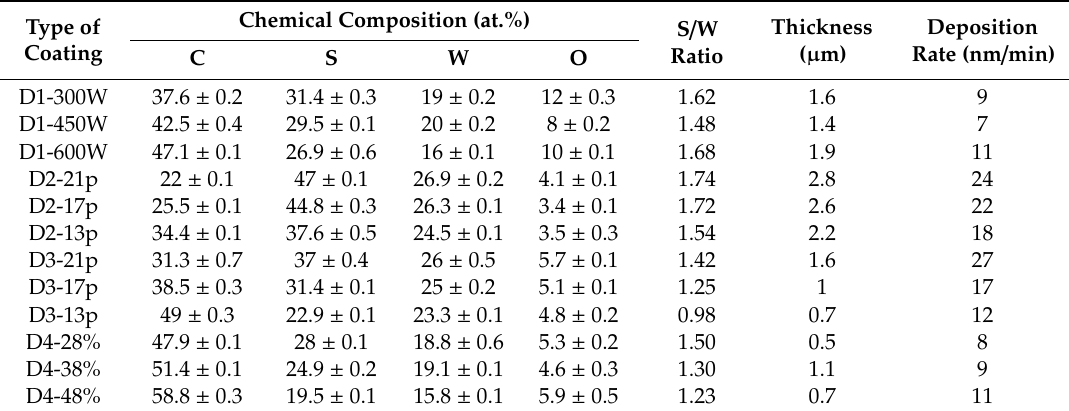
Table 1. Chemical composition, thickness, and deposition rate of the deposited